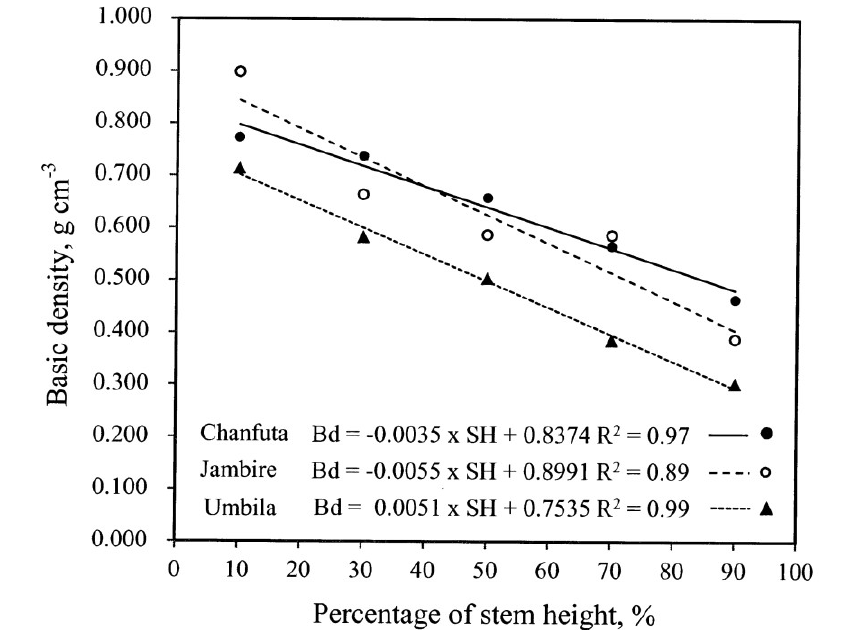
Figure 4. Basic density (Bd) variation along tree